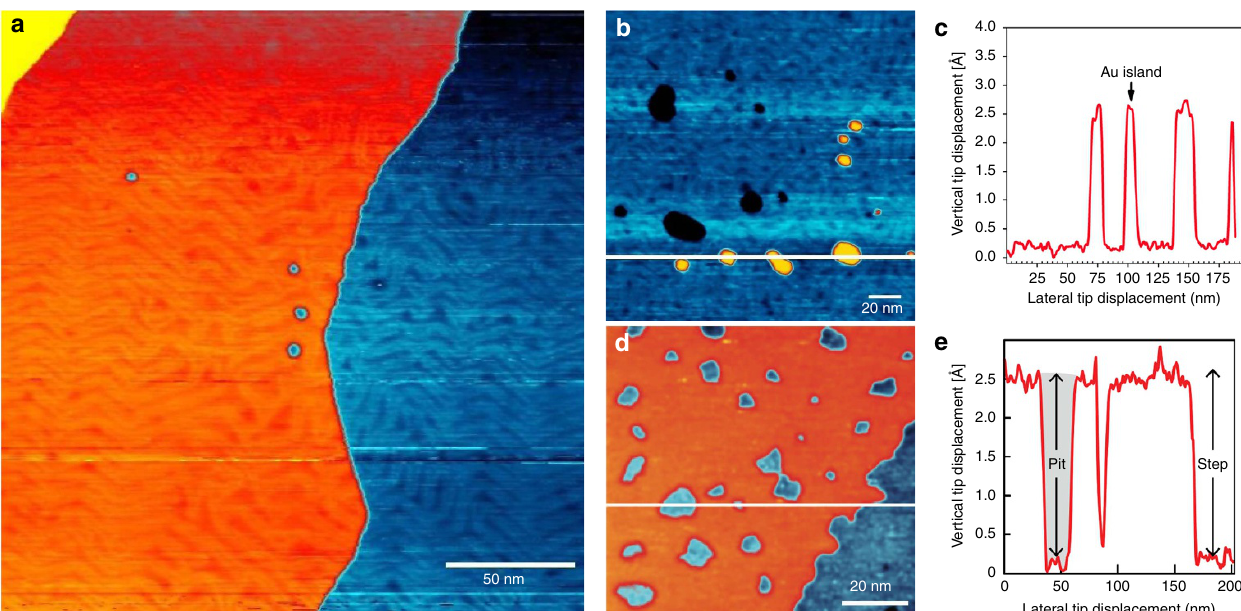
Figure 2 | Scanning tunnelling microscopy imaging of NHC-based films. ( a ) Film prepared in vacuo from 3a illustrating low pit density and adsorbate- modified herringbone reconstruction. ( b ) Lower magnification image of in vacuo deposited film illustrating pits and islands. ( c ) Line profile from b , showing 2.3Å step height as expected for NHC-covered layers separated by a single height step of one gold atom. ( d ) Lower magnification image of solution- deposited film of 3a illustrating pit density. ( e ) Line profile through pits from d .